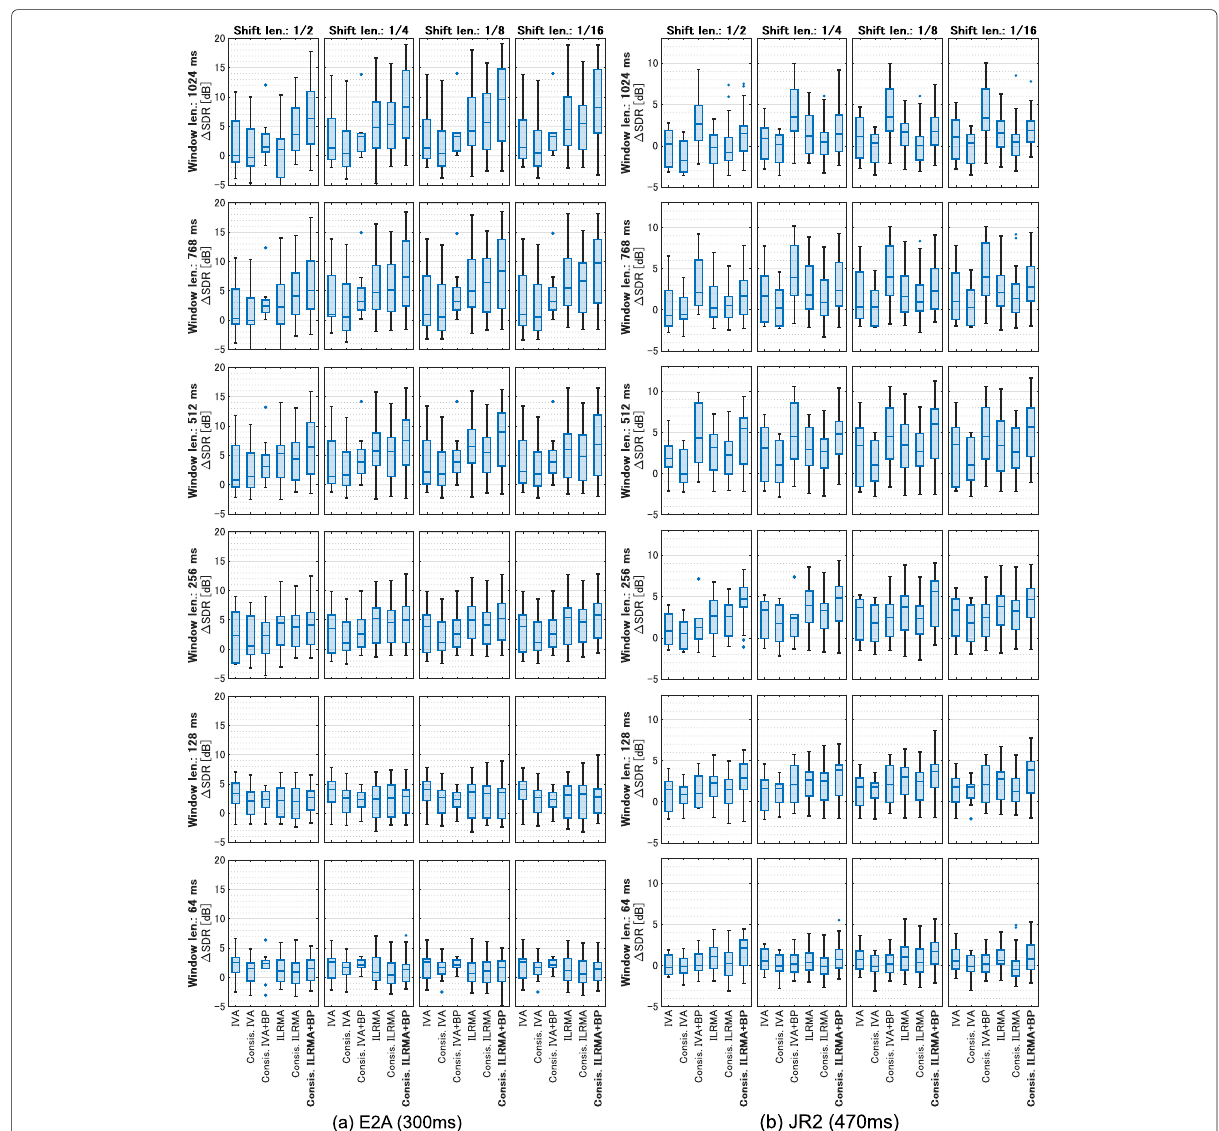
Fig.14 Average SDR improvements for synthesized speech mixtures (speech 1–10) with a E2A and b JR2 , where Hamming window is used in